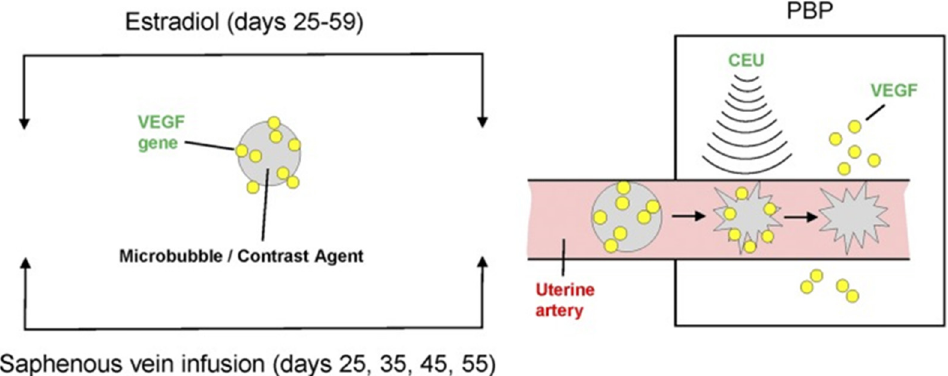
Figure 7. Vector map of the NTC8685–human (h)VEGF 121 –IRES–EGFP. CMV, cytomegalovirus; EGFP, enhanced GFP; HTLV-1, human T-cell leukemia virus type 1; IRES (ECMV), internal riboso- mal entry site (from the encephalomyocarditis virus); PAS, primosomal assembly site; PAS-BH, pri- mosomal assembly site sequence on the pBR322 H strand; PAS-BL, primosomal assembly site se- quence on the pBR322 L strand; pUC, plasmid University of California; SV, simian virus; trpA, tryp- tophan A; VA RNAI, virus-associated RNA I, a type of noncoding RNA that plays a role in regulat- ing translation. Reproduced with permission [82].